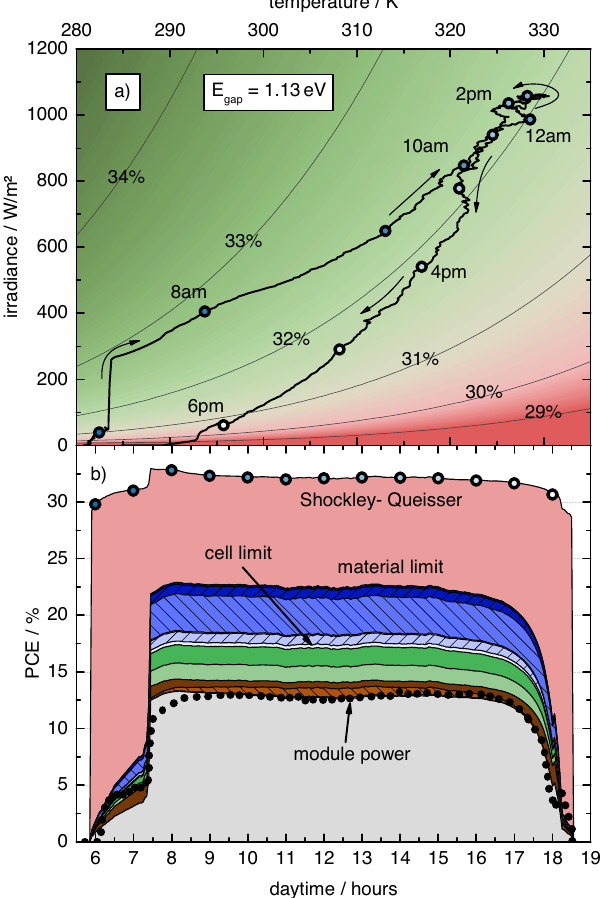
Fig. 7 Trajectory of the operating conditions of the module within the Shockley – Queisser model during the daytime of September 9, 2020. The Shockley – Queisser limit for a band gap of 1.13 eV is plotted as a colormap in graph a) as a function of temperature and irradiance. The black line represents the course of the conditions during the considered day. The same curve is shown in graph b) in combination with the actual module power conversion ef fi ciency (PCE). All loss mechanisms have the same color coding as in Fig. Table 2 Comparison of ideal cell widths and ef fi ciencies for different improvement implementations described in the main text. In the fi rst row, the standard reference module is used, while in the second row, only the interconnect area was reduced, and in the last row, all improvements are implemented (sheet resistance and transmittance of the transparent conductive oxide (TCO) layer, encapsulant transmittance, interconnect and edge area). All simulated modules have the same area of 1200 × 600 mm 2 . Therefore, the ideal cell width determines the amount of monolithically interconnected cells and hence the absolute module voltage. All optoelectrical parameters are shown, including the open circuit voltage V oc , short circuit current (density) I sc and j sc , fi ll factor FF and power conversion ef fi ciency PCE.